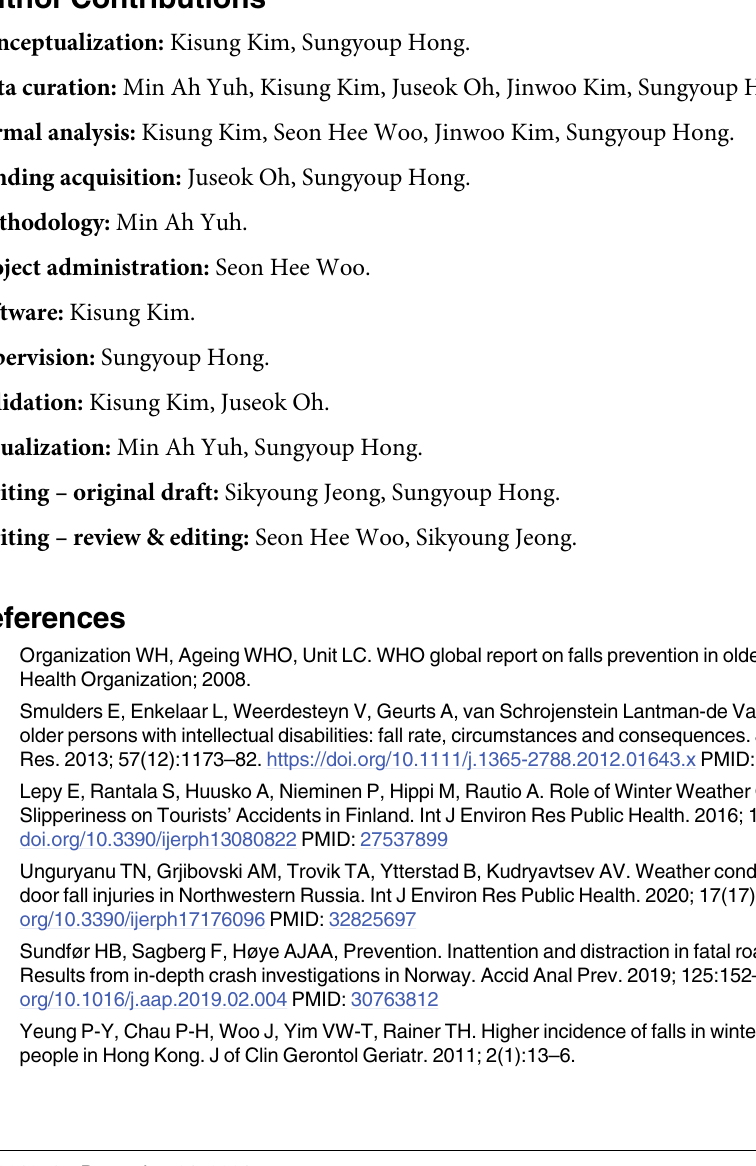
S2 Fig. Distribution of daily fall injuries by weekday for metropolitan and rural